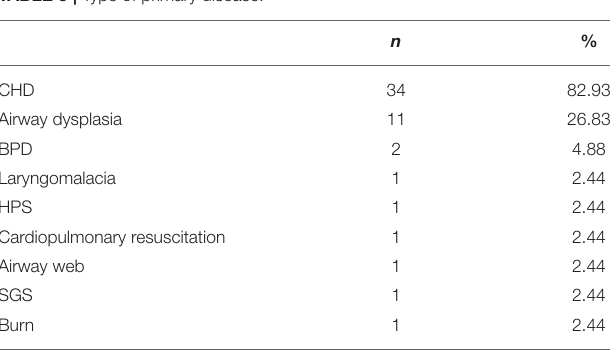
TABLE 3 | Type of primary disease.